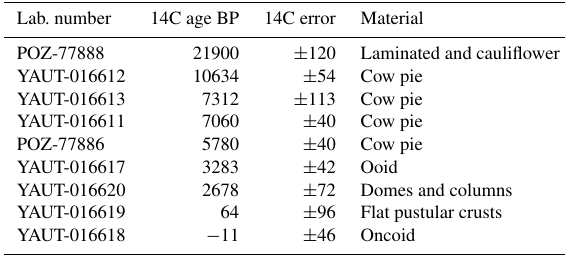
spaces; Della Porta, 2015; Pace et al., 2016), are common, but there is a lack of living microbial mats. In the submersed